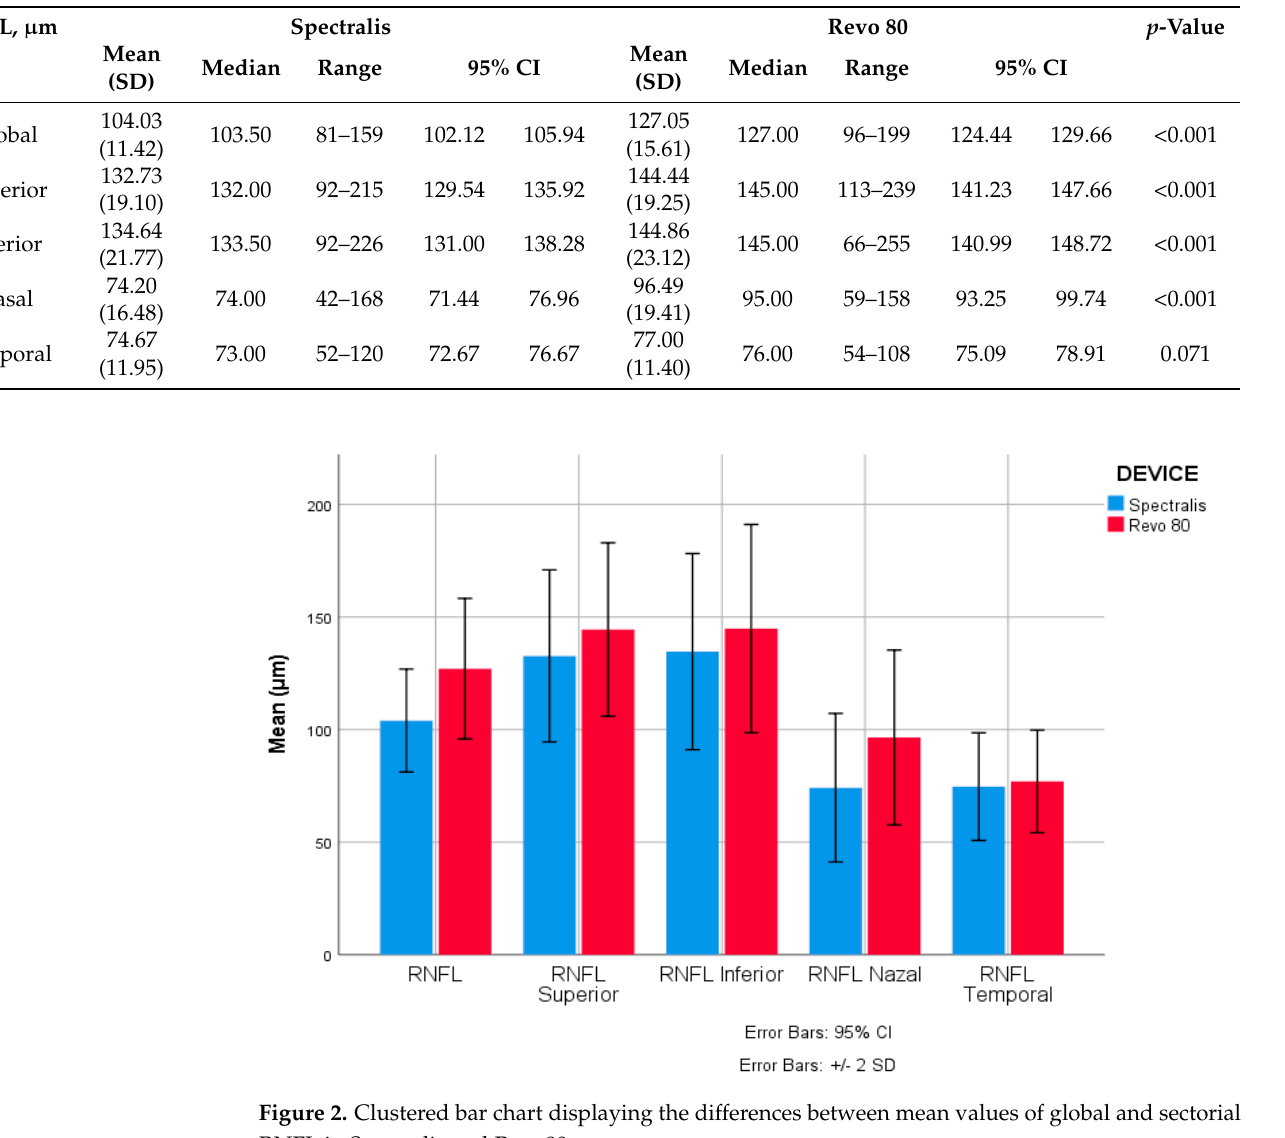
Figure 3. Bland–Altman chart of Spectralis and Revo80 measurements for Global RNFL, where ◦ is di ff erence, -- mean, and -- lower and upper 95% limit values. 3.4. Side-To-Side Di ff erences Going further, we investigated the in fl uence of eye laterality on our parameters. Global RNFL thickness did not register signi fi cant di ff erences ( p = 0.306), with 103.31 ± 18.56 µm, 95% CI (101.10–105.53) mean value in the right eyes and 104.74 ± 26.50 µm, 95% CI (101.58–107.90) in the left eyes on the Spectralis measurements, respectively. In regard to sectorial variability, superior and inferior RNFL means revealed higher values in the left eye (Table 3).